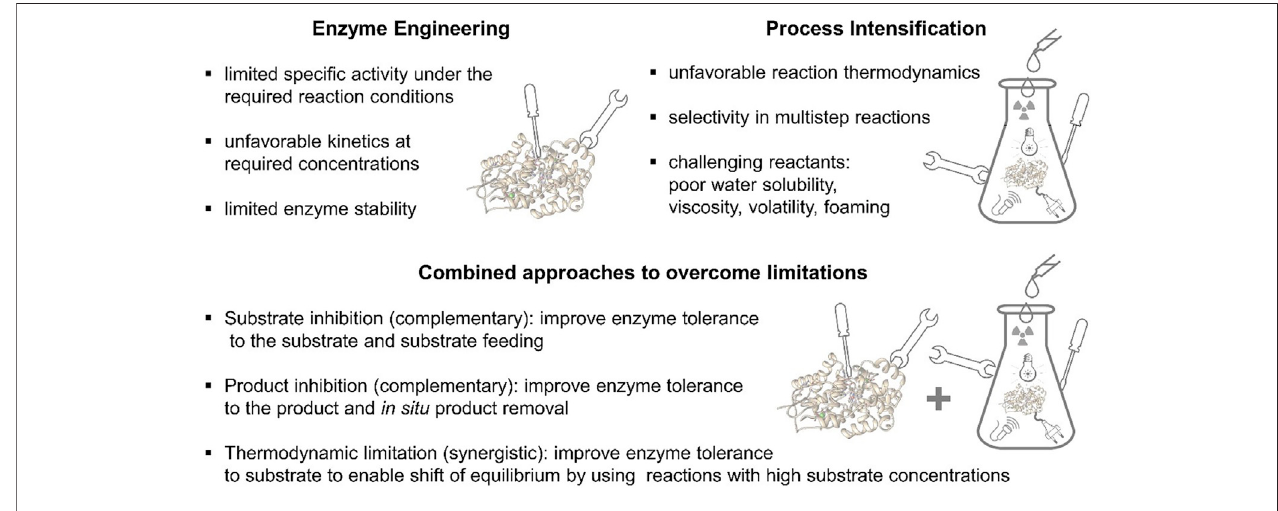
FIGURE 1 | Differentiation and overlap between enzyme engineering and PI (detailed description in the